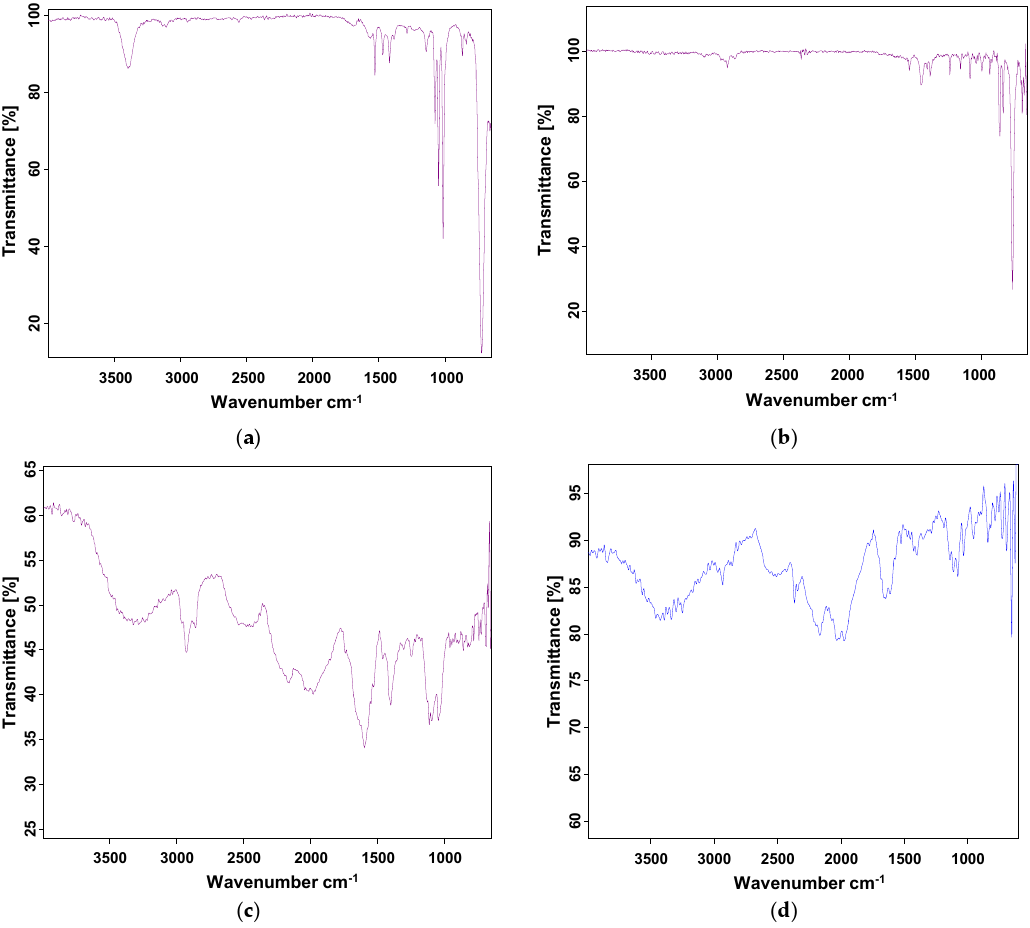
Figure 4. FT-IR spectra of ( a ) NMPY, ( b ) 3MT and ( c , d ) PMPY-Tw20/P3MT/OLC 45 electrodeposition onto OLC 45 sample with galvanostatic and potentiostatic method ( c ) 5 mA/cm 2 , ( d ) 1.2 V with 5:1 molar ratio for MPY-TW20:3MT and permitted for 20 min.